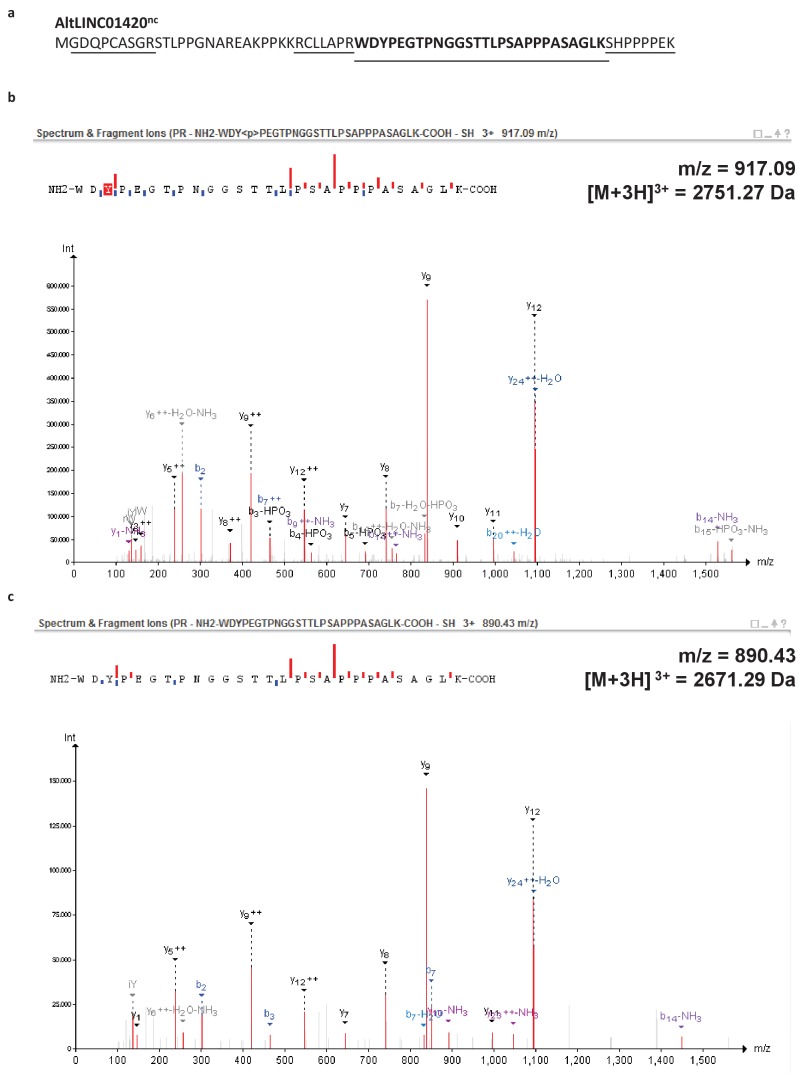
Example of a phosphorylated peptide in mitosis - alternative protein AltLINC01420nc (LOC550643, IP_305449.1).(a) AltLINC01420nc amino acid sequence with detected peptides underlined and phosphorylated peptide in bold (73,9% sequence coverage). (b) MS/MS spectrum for the phosphorylated peptide (PeptideShaker graphic interface output). The phosphorylation site is the tyrosine residue, position 2. (c) MS/MS spectrum for the non-phosphorylated peptide. The mass difference between the precursor ions between both spectra corresponds to that of a phosphorylation, confirming the specific phosphorylation of this residue in mitosis.